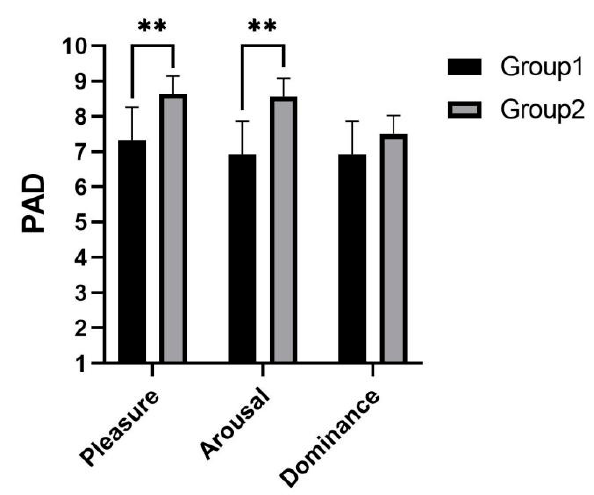
Figure 10. Emotion score of telephone task. ** indicates significant difference ( p < 0.01).